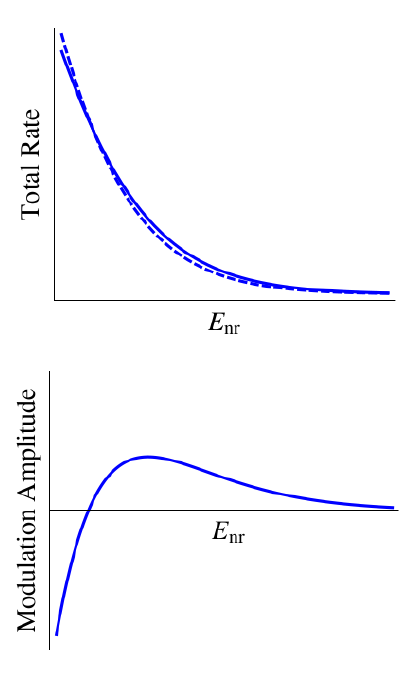
Figure 11: The difference in the recoil energy spectrum (top) comparing the maxi- mum (solid line) and minimum (dashed line) times of the year for an annual mod- ulation of WIMP interactions. The bottom graph shows the ratio of the modulation amplitude for those two cases. Figure excerpted from Ref. [ 19 ]